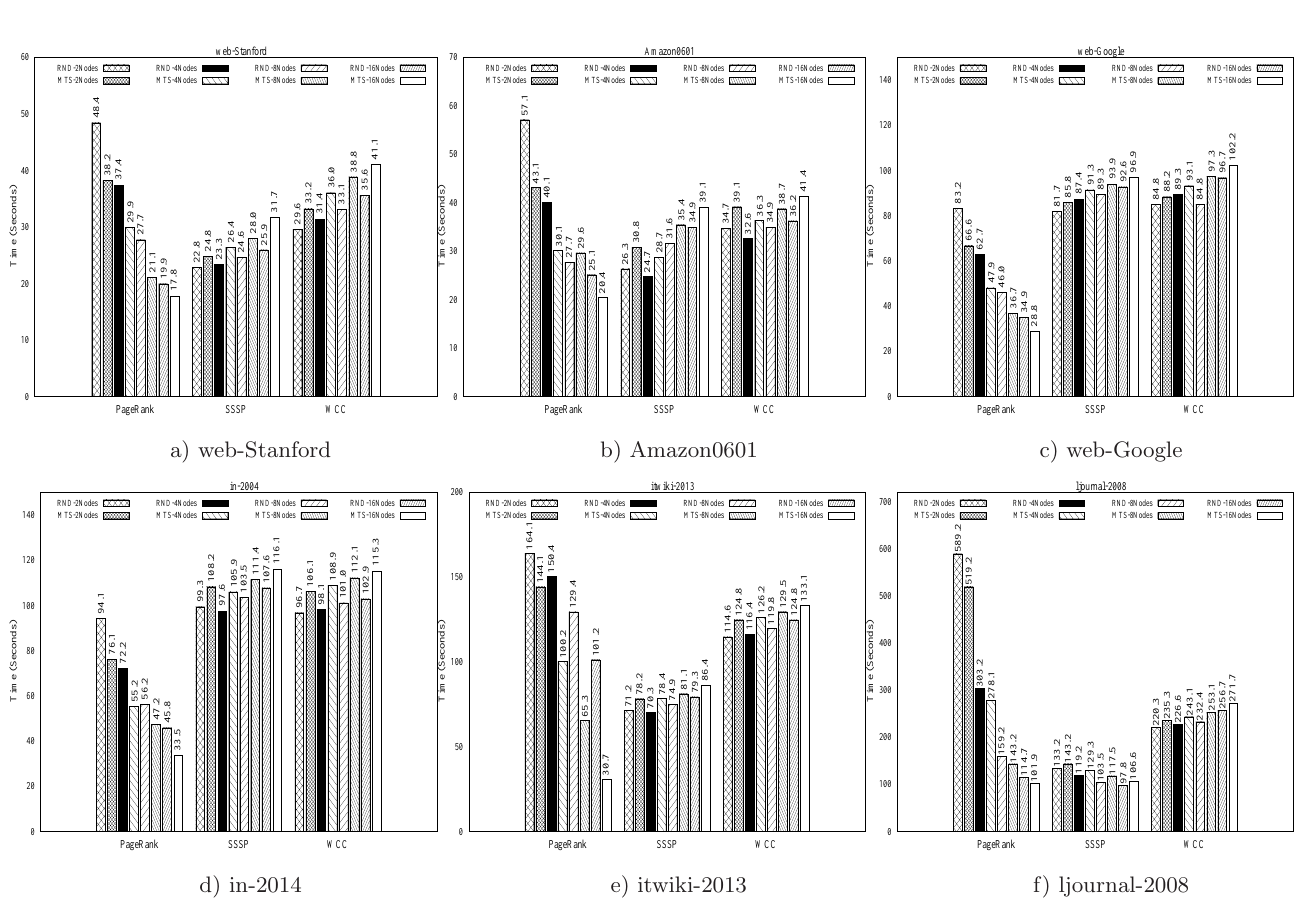
Figure 8. Time performance metric for web-Stanford, Amazon0601, web-Google, in-2004, itwiki-2013 and ljournal-2008